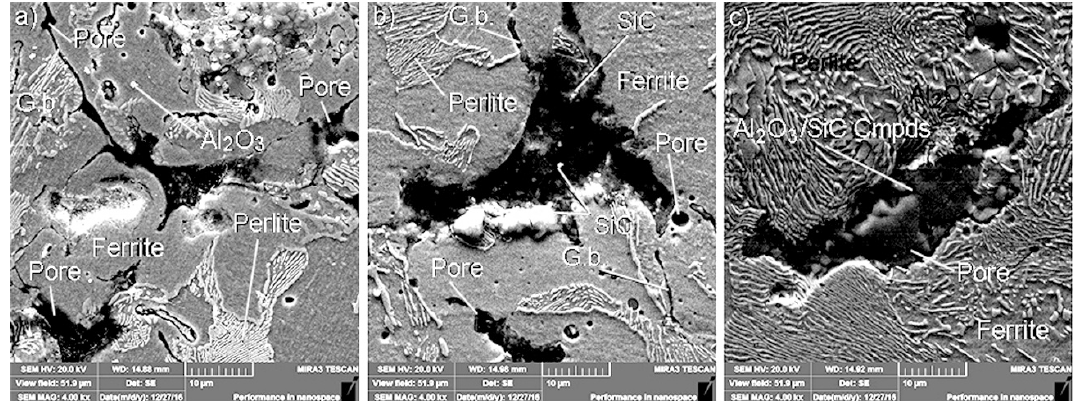
Figure 2. Microstructures of composites tested: ( a ) 1 wt% Al 2 O 3 addition; ( b ) 1 wt% SiC addition; ( c ) 1/3 wt% Al 2 O 3 + 1/3 wt% SiC + 1/3 wt% C addition; abbreviations used: G.b.—grain boundaries, Cmpds—complex compounds based on Al 2 O 3 and SiC.